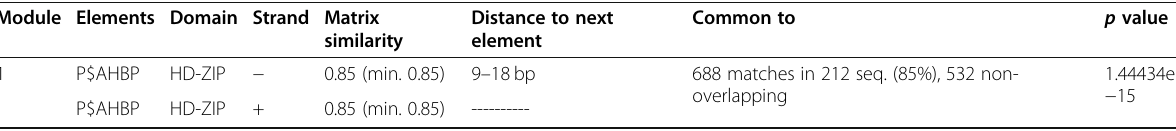
Table 2 Cooperative module found in 85% of the drought responsive promoters Module Elements Domain Strand Matrix